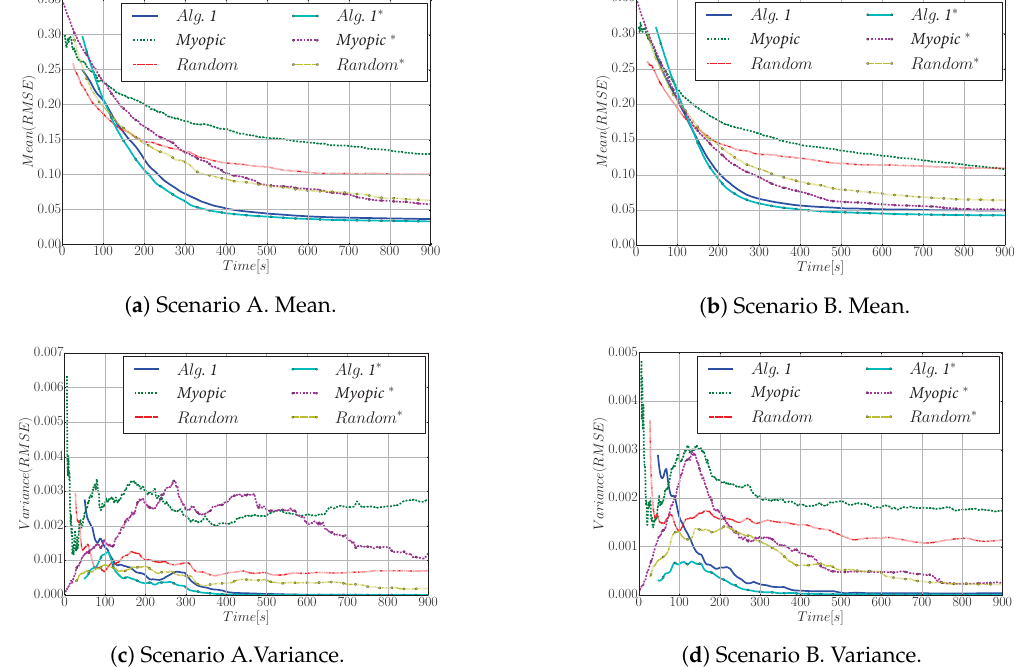
Figure 6. RMSE between the estimation of the process and the ground truth. Top: scenario A. Bottom: scenario B. We represent the mean and variance of the RMSE over the 40 simulations we carried